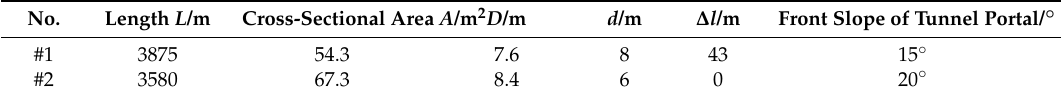
Table 1. Structural parameters of the tunnels.